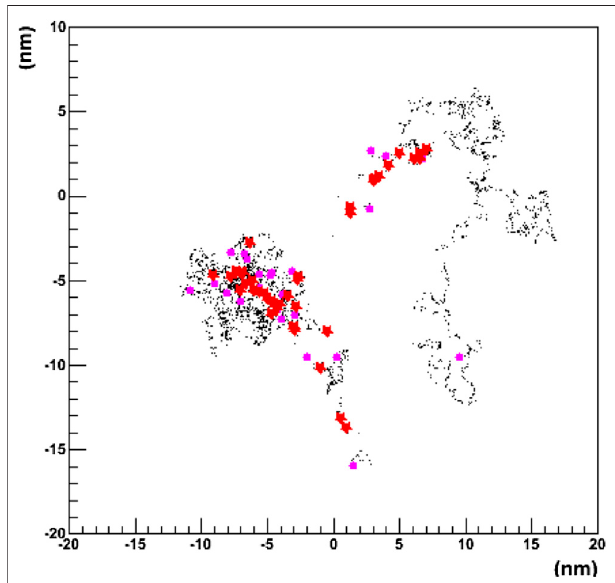
FIGURE4| Projected2Dpatterngeneratedbyasingle1 keVelectron in liquid water using the GEANT4-DNA physics processes. The primary particle originates at the (0,0) position. Different colors represent different physics processes